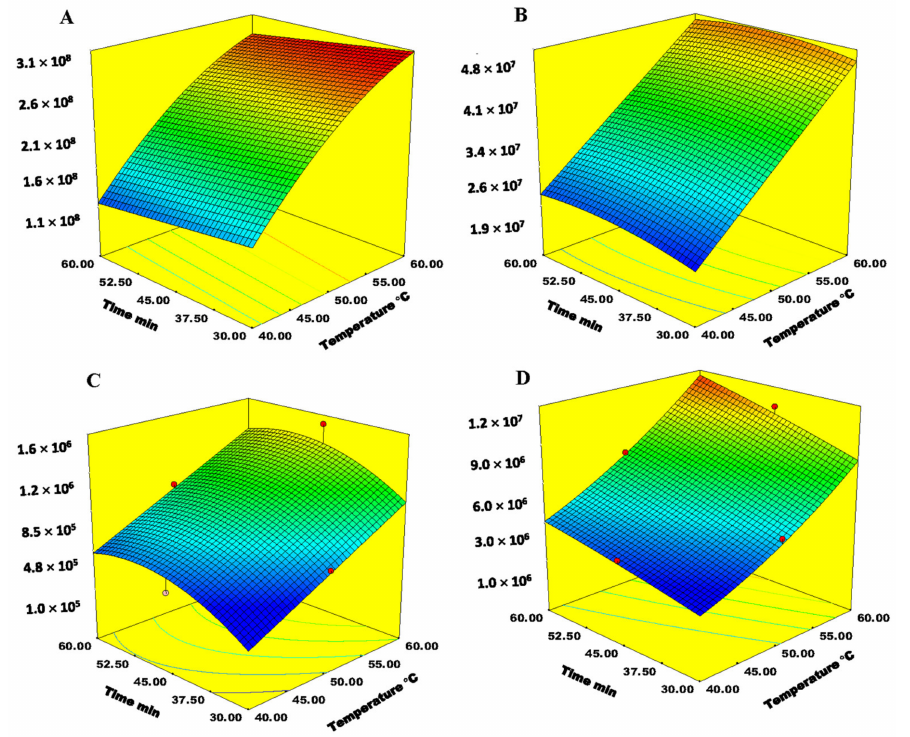
Figure 3. Response surface plot for interaction between extraction temperature and exposure time for free ( A ) aldehydes, ( B ) alcohols, ( C ) monoterpenes and ( D ) sesquiterpenes.